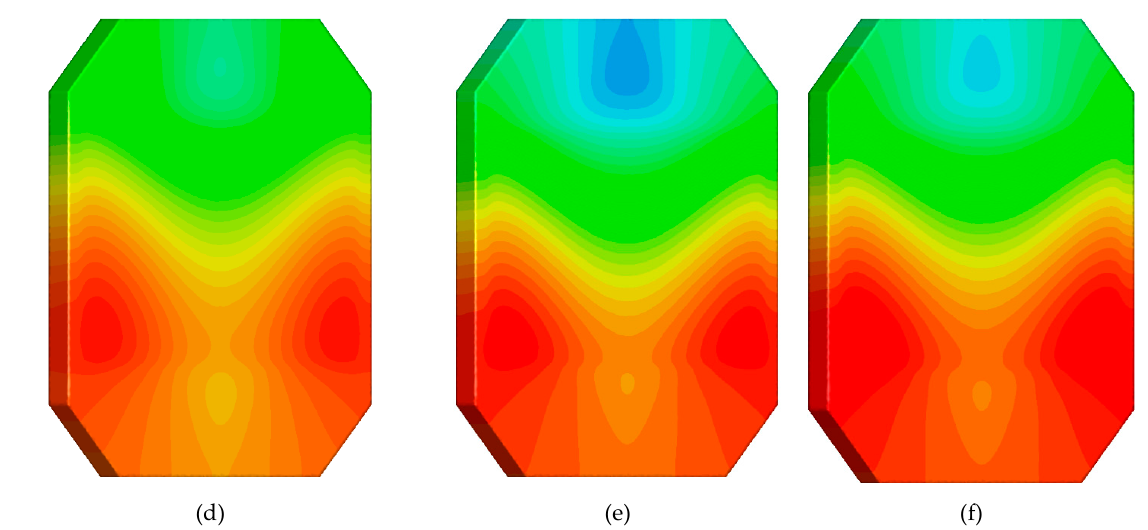
Figure 6. Three-dimensional temperature contour at the middle plane (upper) and the part underneath the WMCHS (bottom) for Al 2 O 3 and CuO water-based NFs at Re = 500 ( a – c ) and 1500 ( d – f ). Figure 7 indicates the thermal resistance of the WMCHS for water/Al 2 O 3 and water/CuO NFs at three different Res of 500, 1000, and 1500. As can be seen, the addition of both NPs decreases the value of the WMCHS thermal resistance, which is desirable. Compared to the water/CuO Na, using the Al 2 O 3 NPs in the base fluid creates lower thermal resistance in the WMCHS. Increasing the Re also decreases the thermal resistance of the WMCHS. The average temperature decrease in the WMCHS leads to a decline in its thermal resistance by enhancing the Re and adding NPs.